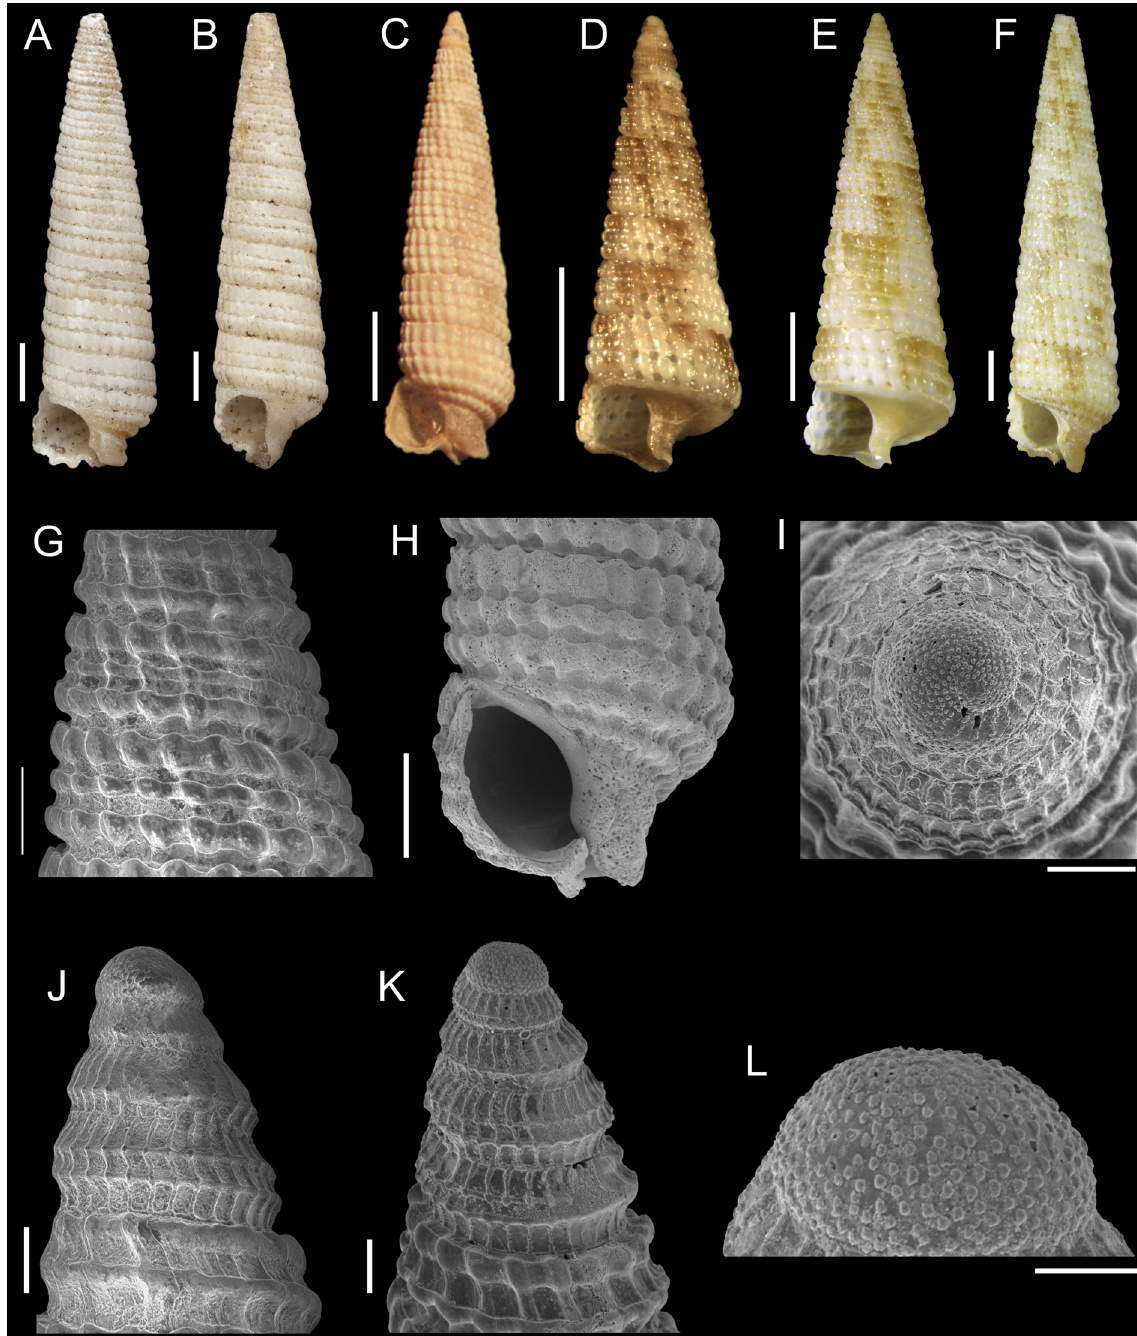
Fig. 90. Latitriphora albida (A. Adams, 1854). A . Syntype, NHM 196563. B . Syntype, NHM 196564. C . MNRJ 18625*, 5.12 mm. D . MNRJ 31525*, 3.43 mm. E . MNRJ 34825*, 5.17 mm. F . MNRJ 33123*, 9.08 mm. G, J . Same shell as E. H . Same shell as C. I, K–L . Same shell as D. Scale bars: A–F = 1 mm; G = 200 µm; H = 500 µm; I–K = 100 µm; L = 50 µm . Photo credits A–B: Andreia Salvador